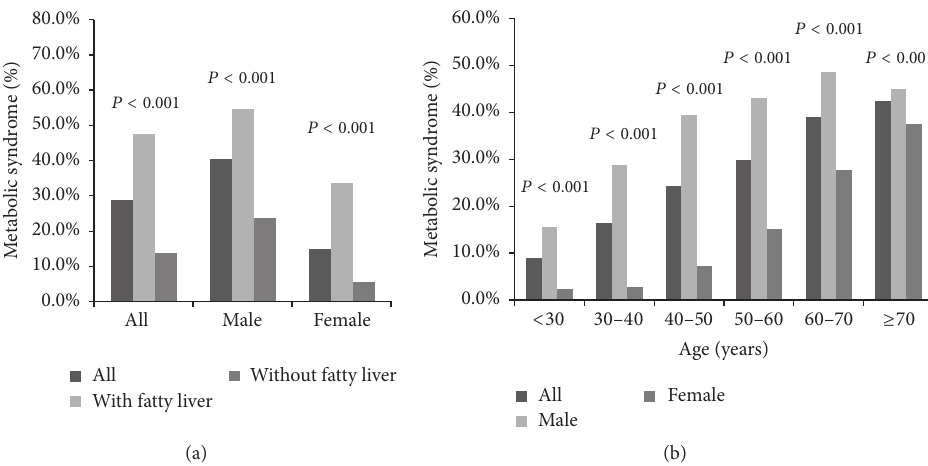
Figure 2: (a) The prevalence of metabolic syndrome divided by the status of fatty liver. (b) The prevalence of metabolic syndrome stratified by age and